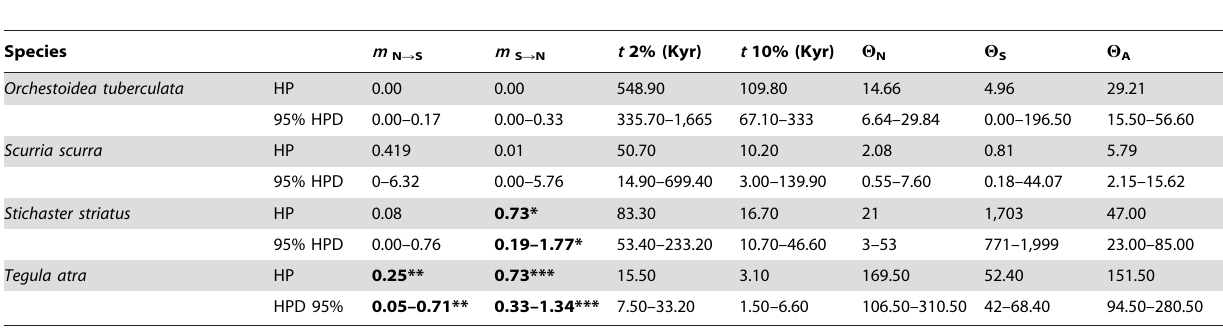
Table 7. Estimates of migration rates ( m ) in each direction across 30 u S, time of divergence ( t ) between biogeographic regions, and genetic diversities ( H ) (north= H N ; south = H S ; ancestral= H A ), based on the isolation-with-migration model implemented in IMa2.